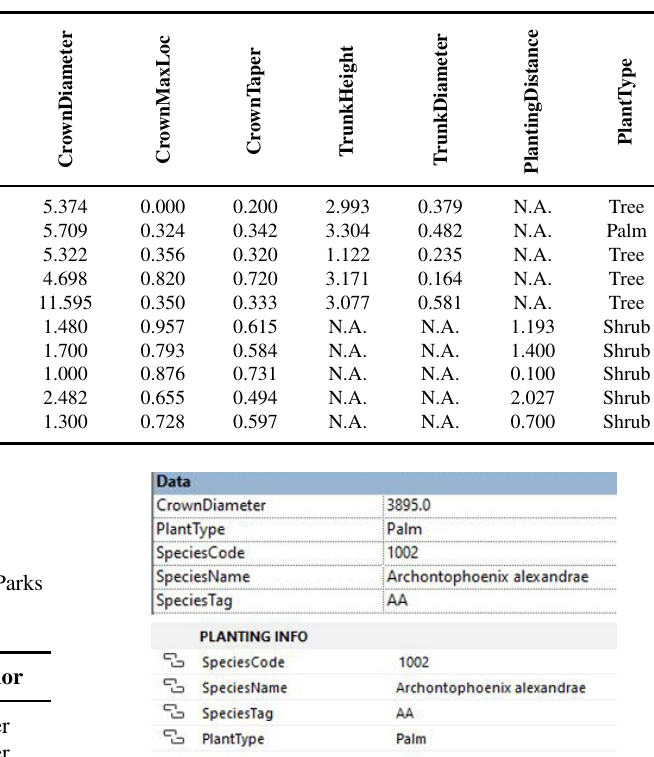
Table 2. A snippet of the vegetation library with some spatial and non-spatial parameter mean values